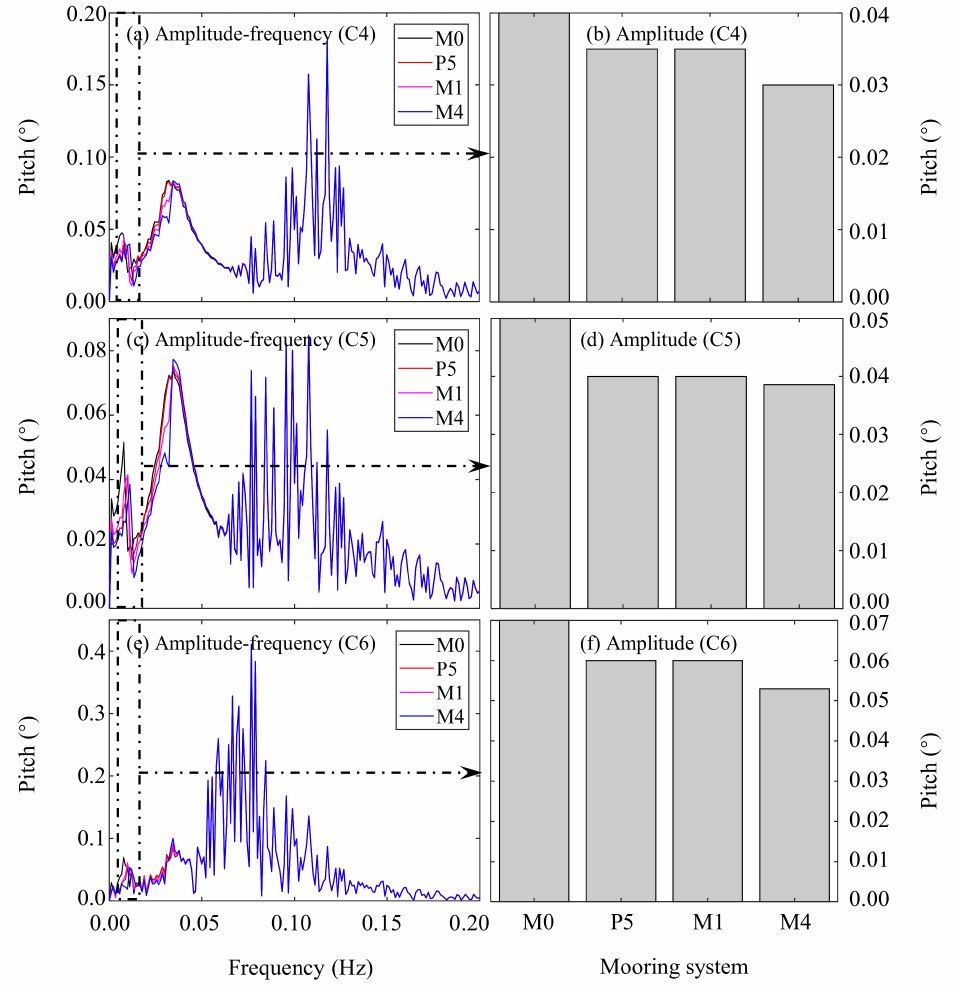
Figure 23. Wind turbine pitch movement in frequency domain with M0, P5, M1, and M4 when under: ( a ) amplitude-frequency (C4); ( b) amplitude (C4); ( c ) amplitude-frequency (C5); ( d ) amplitude (C5); ( e ) amplitude-frequency (C6); ( f ) amplitude